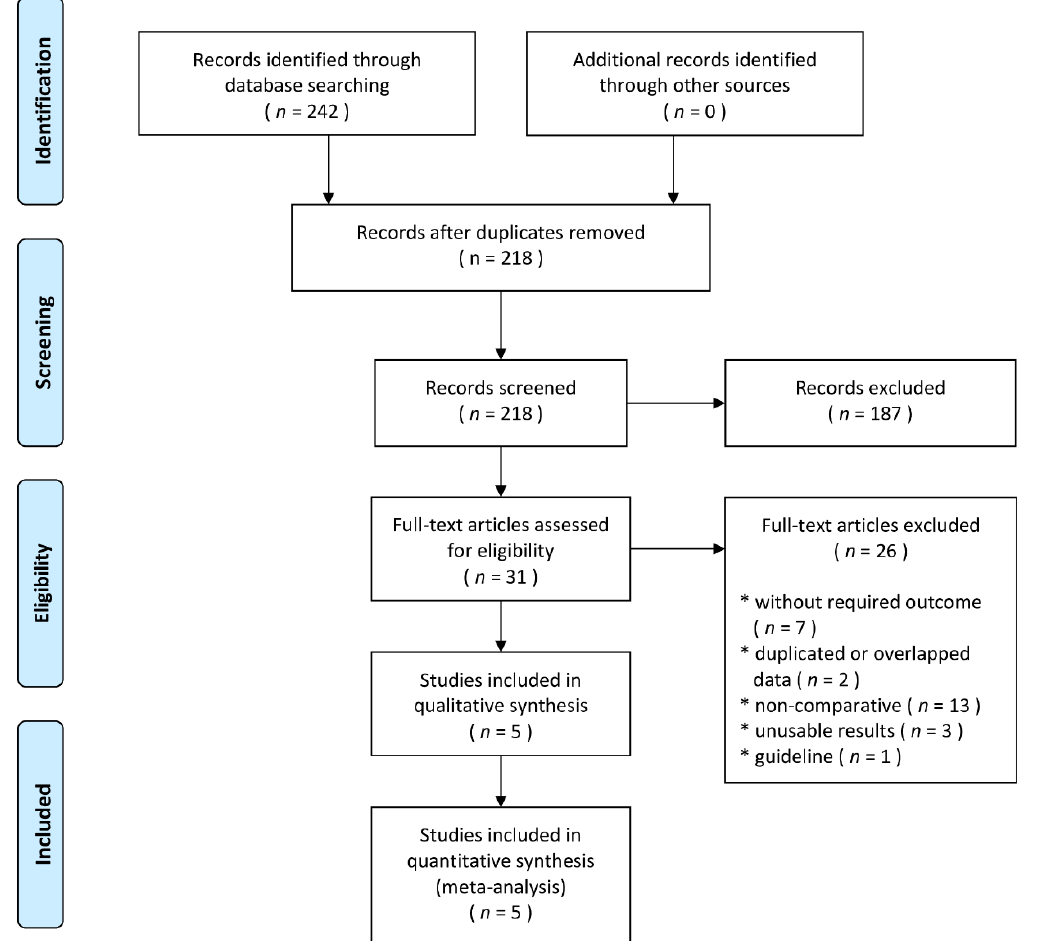
Figure 1. Flow diagram showing stages of database searching and study selection as per Preferred Reporting Items for Systematic reviews and Meta-analysis (PRISMA) guideline.